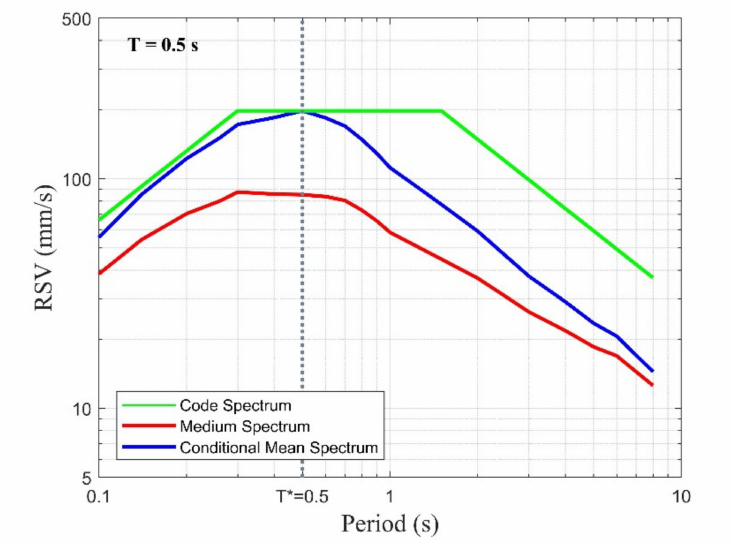
Figure 3. Illustration of the CMS for a 2500-year return period event in